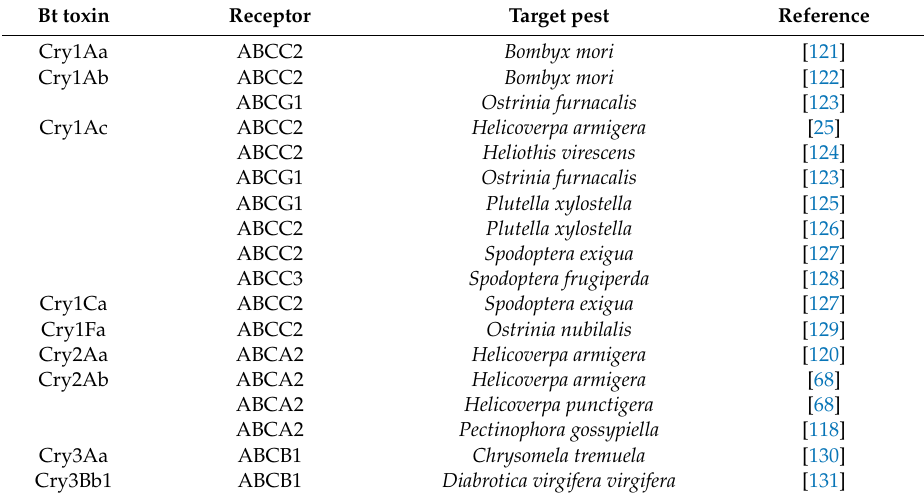
Table 2. Bt toxins and their possible corresponding ABC transporters as receptors in